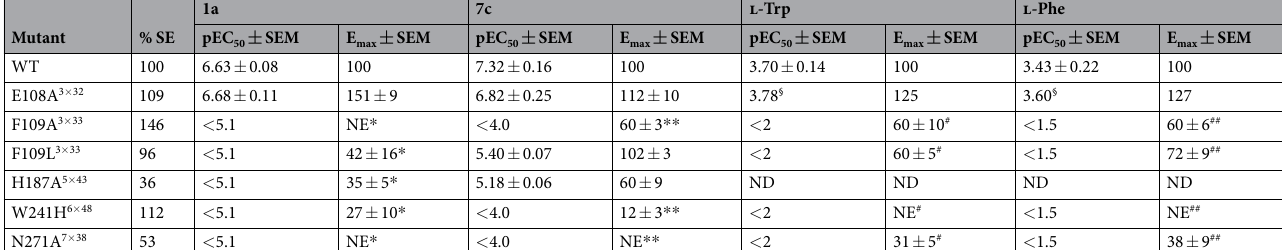
Table 1. GPR139 mutant potencies for 1a , 7c , l- Trp , and l -Phe . The table displays the mutants with effect on 1a (and E108A 3 × 32 ), and a percent surface expression (% SE, normalized to WT = 100%) over 35%. The potencies are presented as mean pEC 50 ± SEM and mean E max ± SEM. The potency of 1a was calculated from three independent experiments conducted in triplicates, and normalized to buffer (0%) and 8 μ M 1a (100%). The potencies of 7c , Trp and Phe are from three independent experiments conducted in duplicates, and normalized to buffer (0%) and 100 μ M 7c or 10 mM Trp or 30 mM Phe (100%), respectively. Remarks: * at 8 μ M, ** at 100 μ M, # at 10 mM, ## at 30 mM, § only one experiment, ND: not determined (not measured) and NE: no effect (loss of activity).